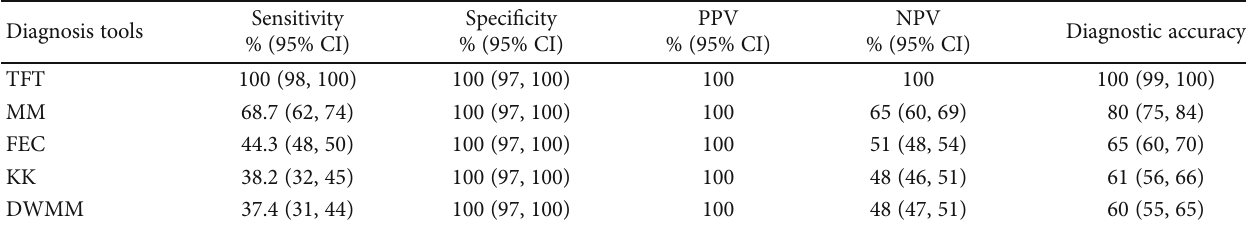
Table 2: Performance of hookworm diagnosis techniques compared to CRS.